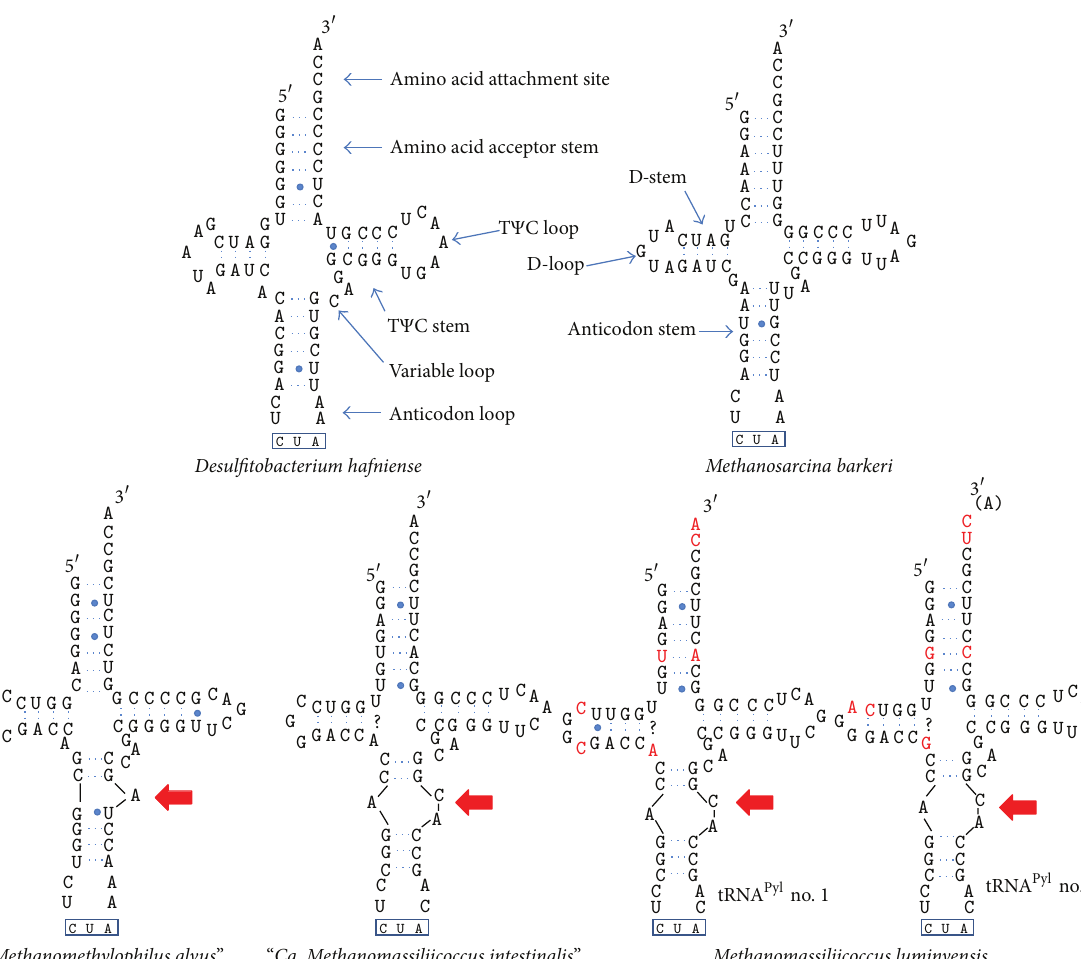
Figure 2: Secondary structure of the tRNA Pyl in the Thermoplasmata-related 7th order of methanogens. The stem-loop structure of the tRNA Pyl in the 7th order of methanogens is shown, deduced by comparison with the structure of this tRNA in bacteria ( Desulfitobacterium hafniense , top left) and in Methanosarcinaceae ( Methanosarcina barkeri , top right), adapted from [1 1, 1 3] . The name of each region of the tRNA is indicated in the upper part. The anticodon CUA (corresponding to the amber codon) is outlined in blue. The red arrows indicate the shortened anticodon stem in the 7th order of methanogens broken by unpaired bases that form an unusual loop in this region. The question marks represent other possible base pairing. For the two tRNA Pyl in M. luminyensis , the modified bases between no. 1 and no. 2 are written in